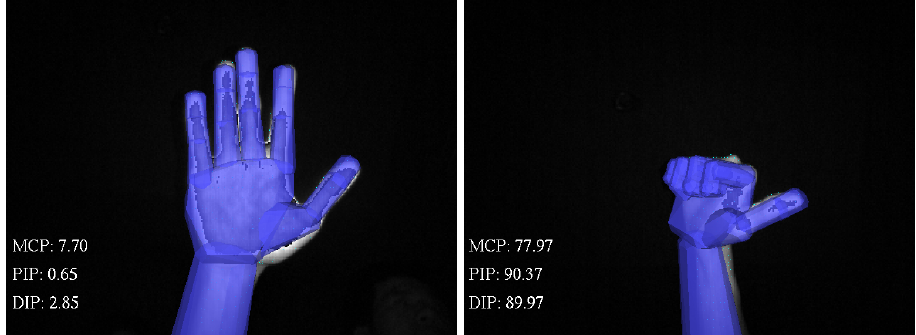
Figure 8. Extension and flexion positions of the hand in the tracking